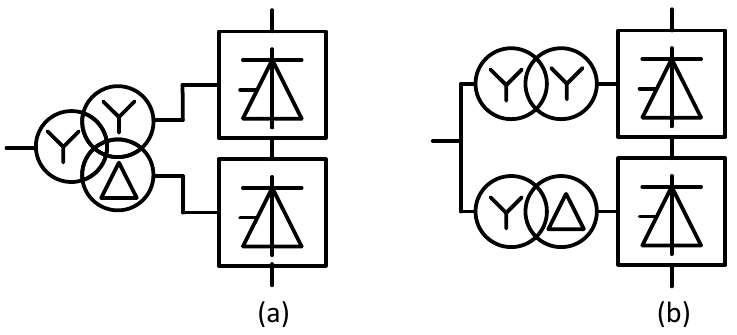
Figure 7. Two 6-pulse bridges forming a 12-pulse CSC using: ( a ) Three-winding converter transformer ( b ) Two two-winding converter transformers.